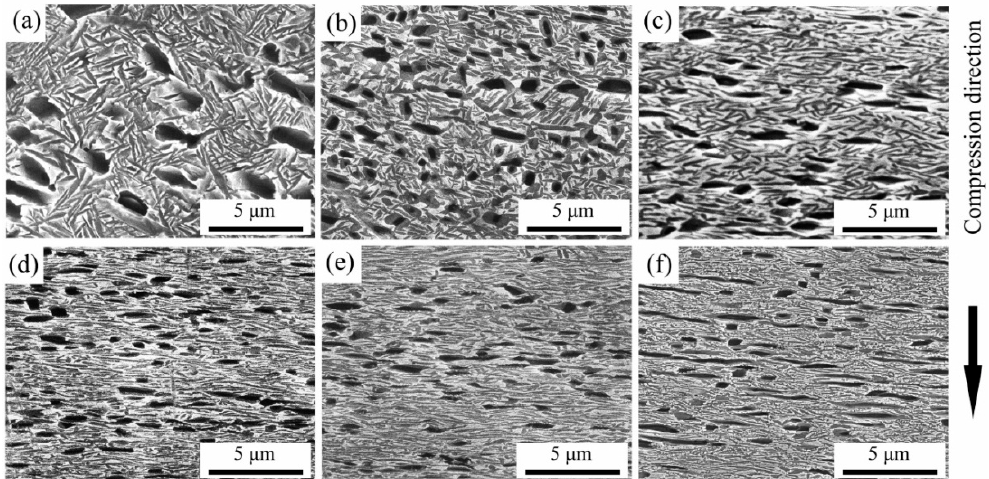
Figure 3. SEM images for the as-rolled and can-compressed samples with di ff erent height reductions: ( a ) as-rolled, ( b ) 25%, ( c ) 50%, ( d ) 60%, ( e ) 65%, and ( f )